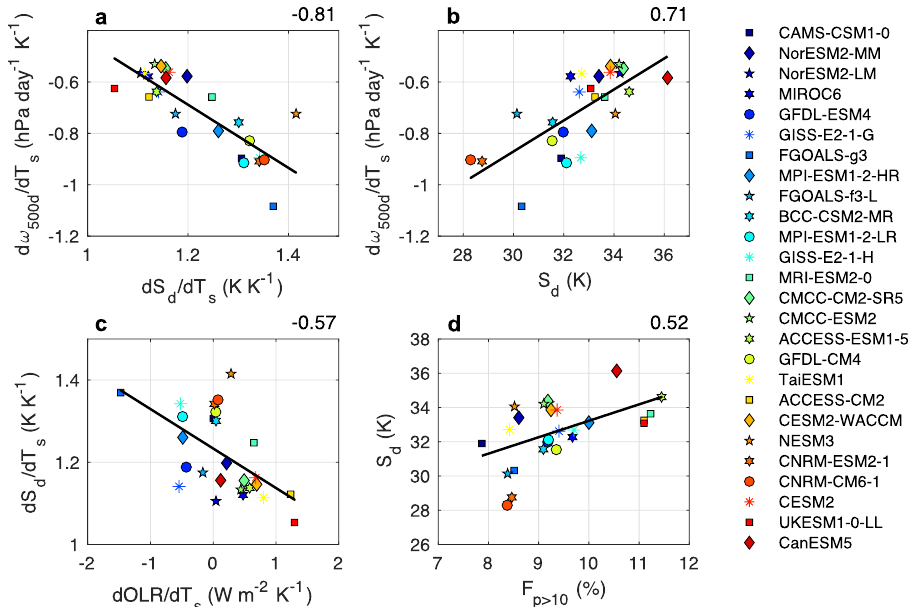
Fig.7|Changesinstaticstabilitywithwarming,aswellasamodel ’ smean-state static stability, are closely associated with subsidence rate changes. The rela- tionship between ( a ) changes in descent region static stability (dS d /dT s ; K K − 1 ) and changesinthesubsidencerate(d ω 500d /dT s ;hPaday − 1 K − 1 ),( b )descentregionmean- state static stability (S d ; K) and d ω 500 d /dT s , ( c ) changes in tropics mean outgoing longwave radiation (dOLR/dT s ; W m − 2 K − 1 ) and dS d /dT s , and ( d) the mean-state frequency of heavy precipitation (F p>10 ; %) and S d for 26 CMIP6 models. The color